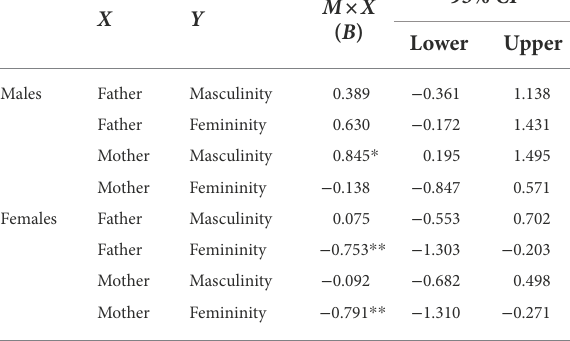
TABLE 5 Urban-rural residence as a moderator of the association between parental education level and explicit mate